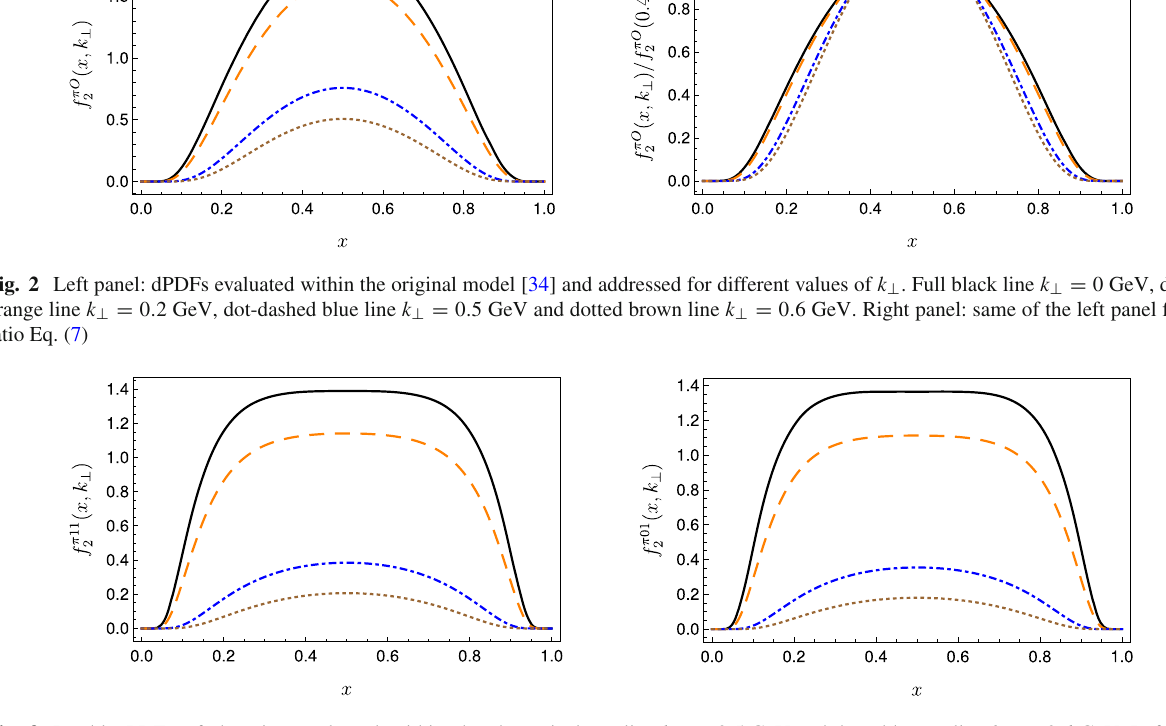
line k ⊥ = 0 . 5 GeV and dotted brown line k ⊥ = 0 . 6 GeV. Left panel for the A = B = 1 configuration. Right panel for the A = 0 , B = 1 configuration